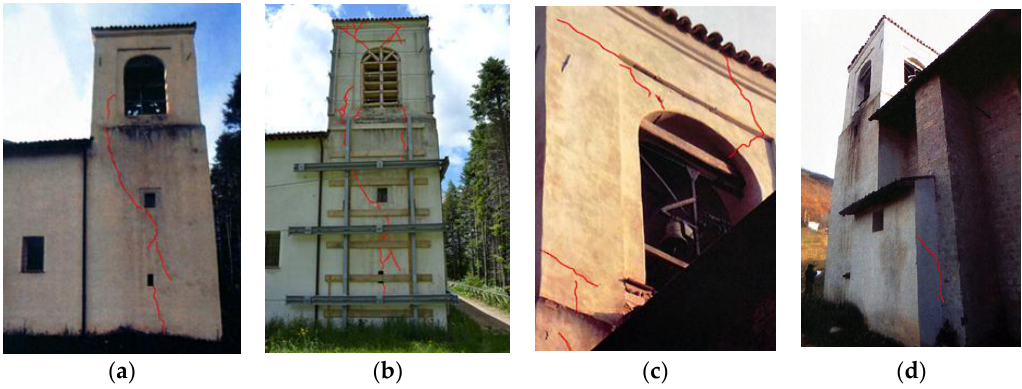
Figure 16. Exterior post-2016 earthquake damage. ( a ) Shear cracks along the height of the bell tower [47]; ( b ) damaged bell tower with provisional interventions; ( c ) torsional and shear cracks [47]; ( d ) diagonal and vertical crack in the annexed building in contact with the buttress of the north wall of the nave [47].